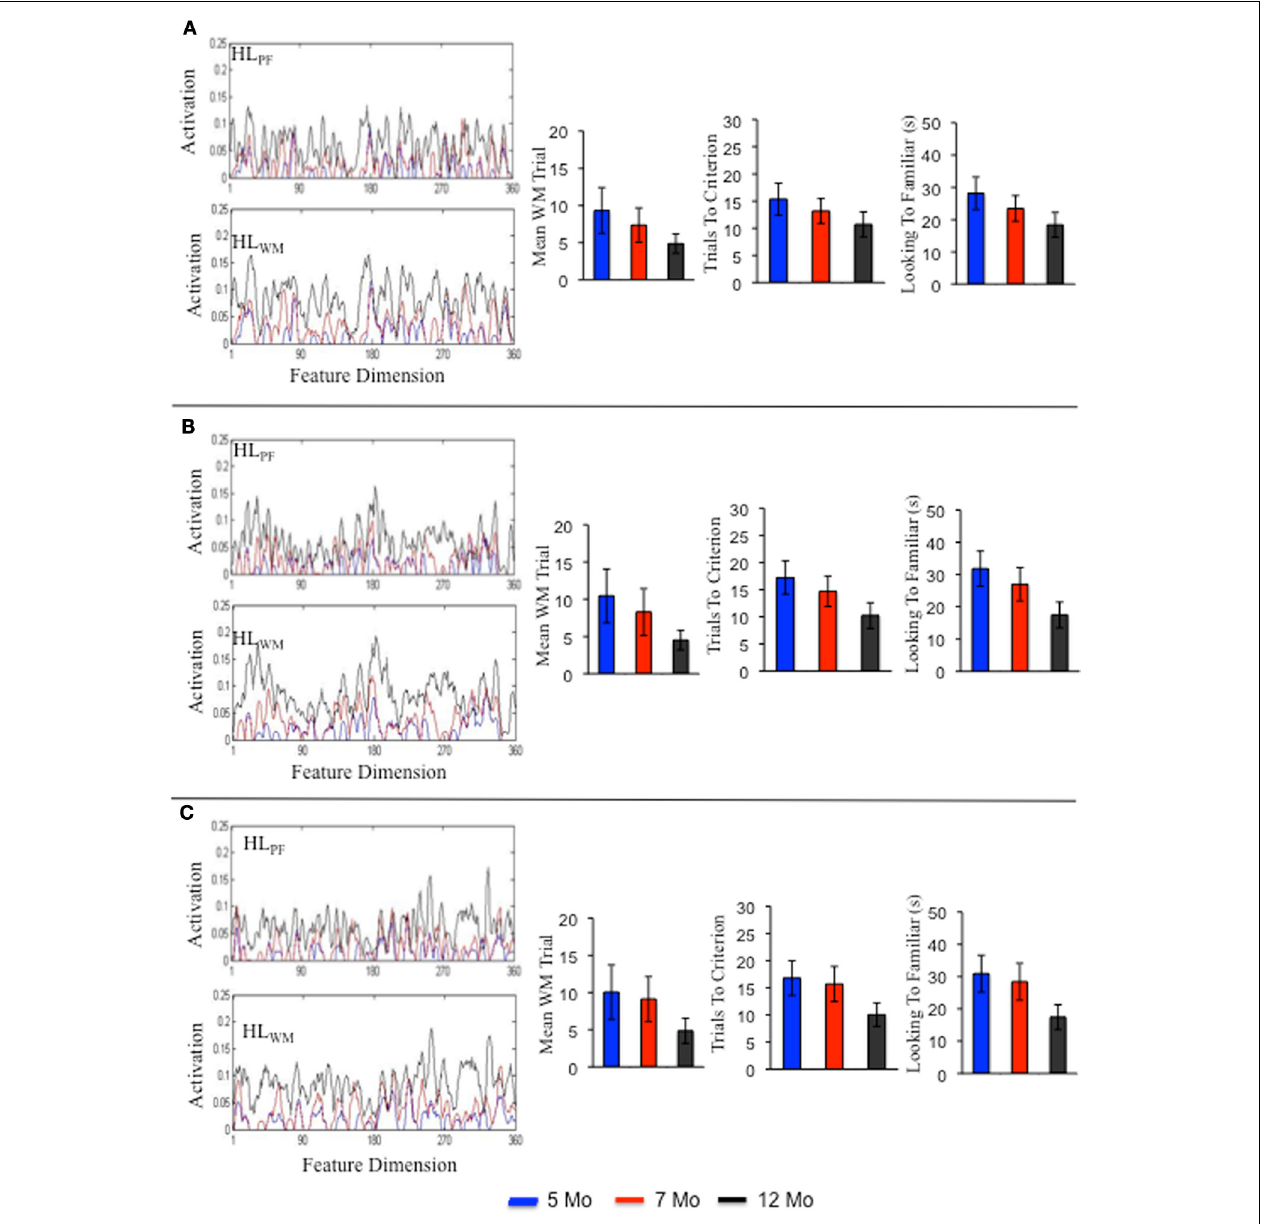
FIGURE 7 | Shows the Hebbian layers and performance in the processing speed task for three individual simulations of the term model. Each panel shows an individual simulation at 5 months (blue), 7 months (red), and 12 months (black).